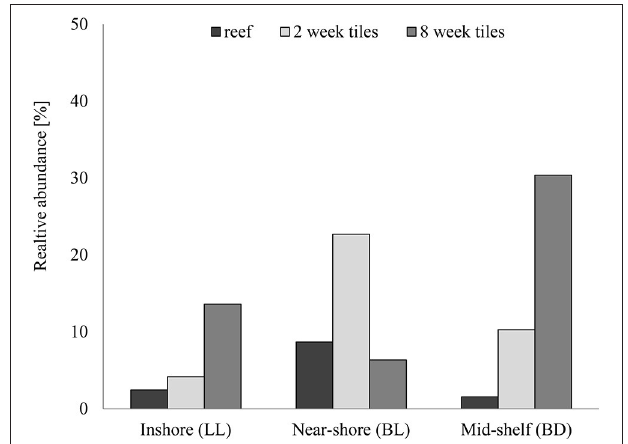
FIGURE 8 | Relative abundance of potentially settlement inducing bacteria on natural substrate ( n = 3) and on artificial settlement tiles after 2 and 8 weeks exposure ( n = 1 and n = 3 respectively) on the reef at the three sampling sites (inshore LL, near-shore BL, and mid-shelf BD). Error bars show standard deviation whenever